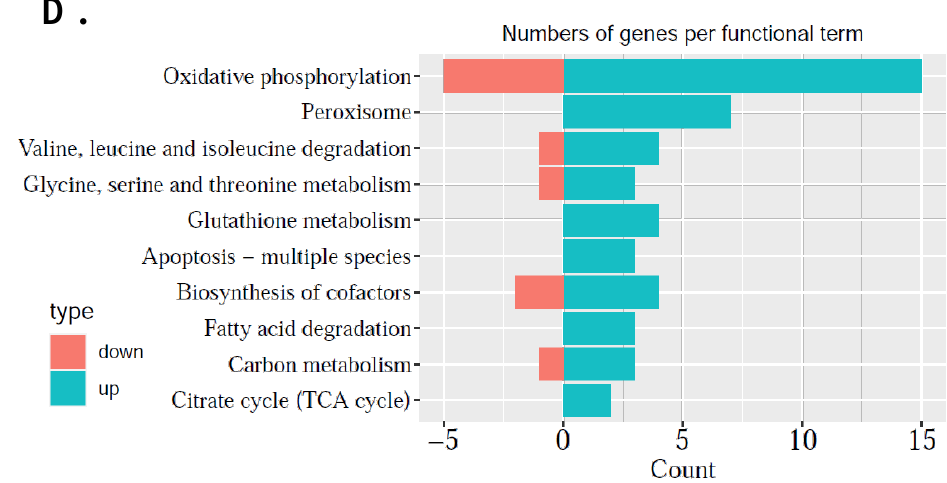
Figure 4. The alterations of mitochondria-related genes in the comparison between M-IVT group and M-IVO group. ( A ) Hierarchical clustering of differentially expressed genes (DEGs) in oocytes between M-IVT and M-IVO based on Z-score normalized FPKM values. Each column represents a sample, and each row represents a gene. Blue indicates lower expression and red indicates higher expression. ( B ) Top significant DEGs in oocytes between M-IVT and M-IVO. ( C ) GO classification of DEGs in oocytes between M-IVT and M-IVO. X -axis represents the GO terms. Y -axis represents the number of genes. ( D ) Kyoto Encyclopedia of Genes and Genome analysis of DEGs in oocytes between M-IVT and M-IVO. X -axis represents the counts. Y -axis shows the name of the statistical